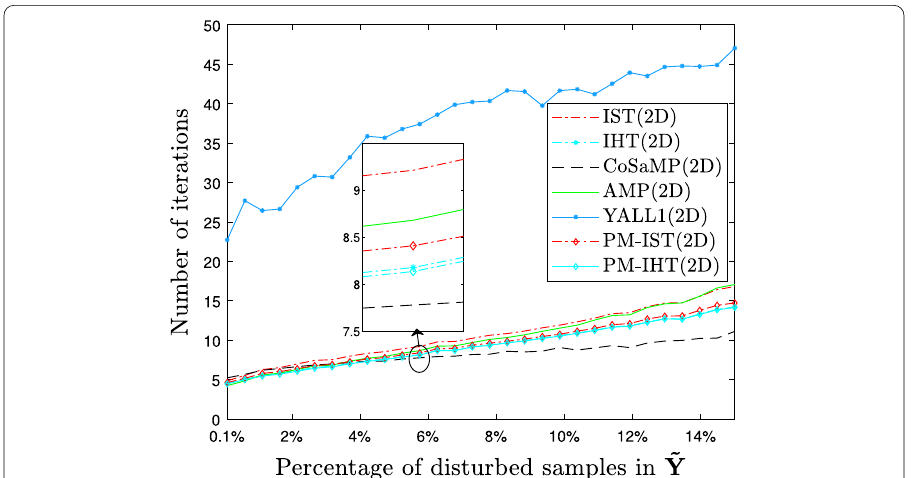
Fig. 8 Number of iterations of 2D algorithms vs. percentage of interference-contaminated samples used in the reconstruction